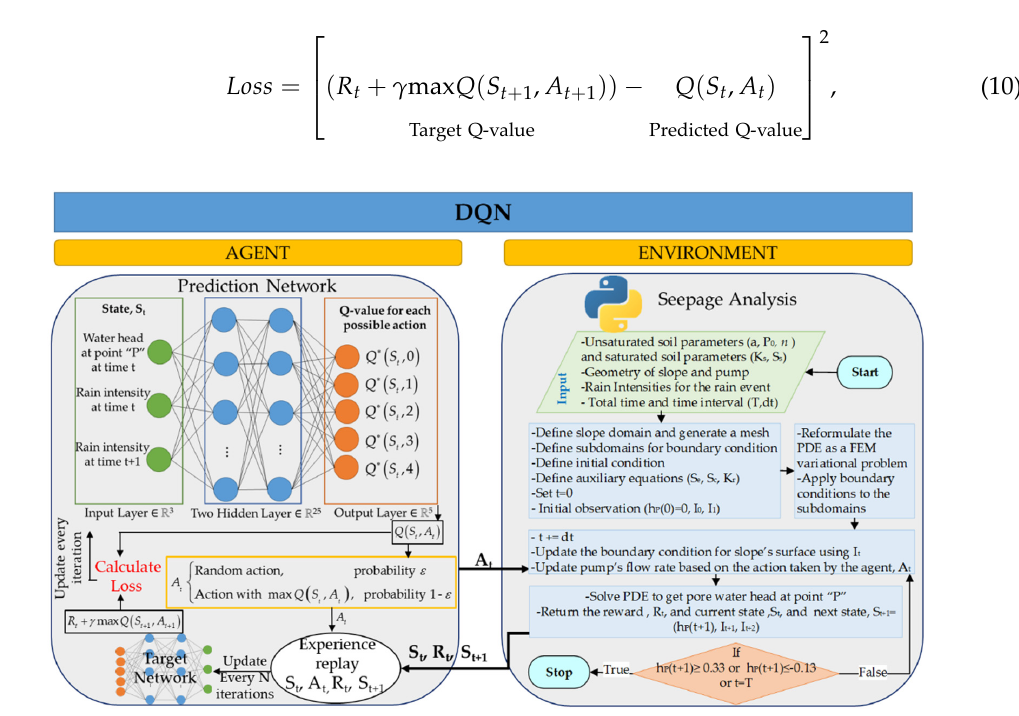
Figure 4. Architecture of the proposed DQN